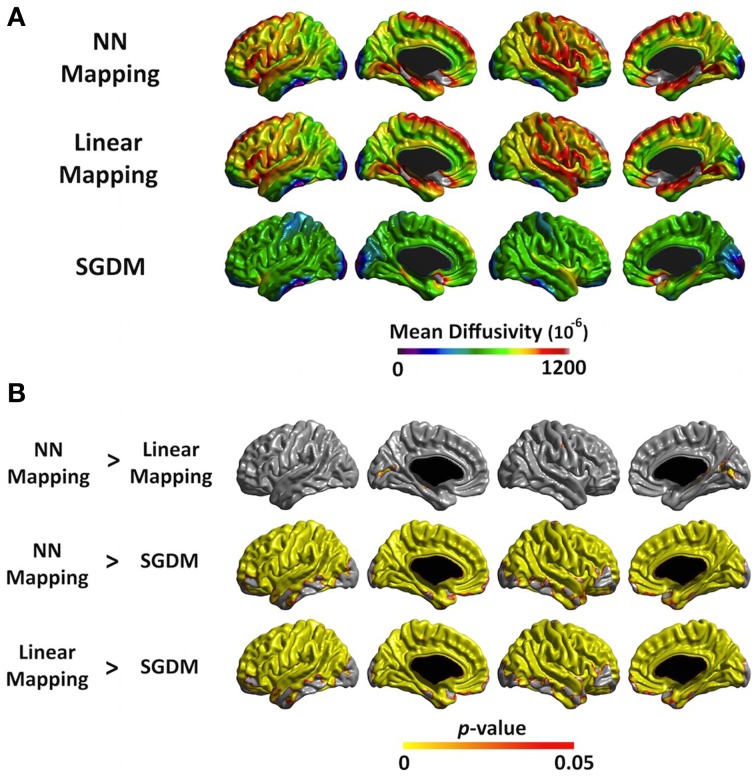
(A) The average MD value map for NN, Linear and SGDM method in ANTs-SyN registration. The color scale on the bottom represents the MD values with a range of 0–1200−6. (B) Statistical maps of the differences in MD values among the three methods in ANTs-SyN registration. The color scale on the bottom represents the multiple comparison corrected p < 0.05.